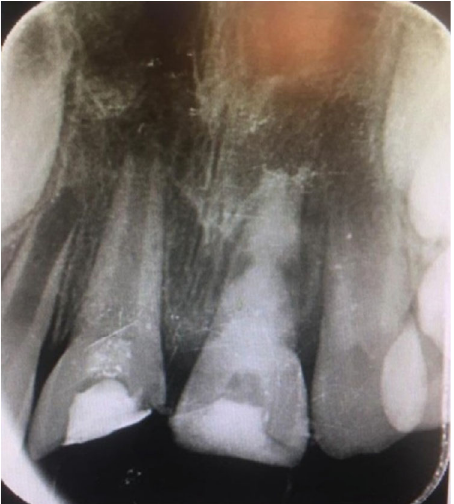
Figure 6: Calcium hydroxide was applied as intracanal medicament to stop the external